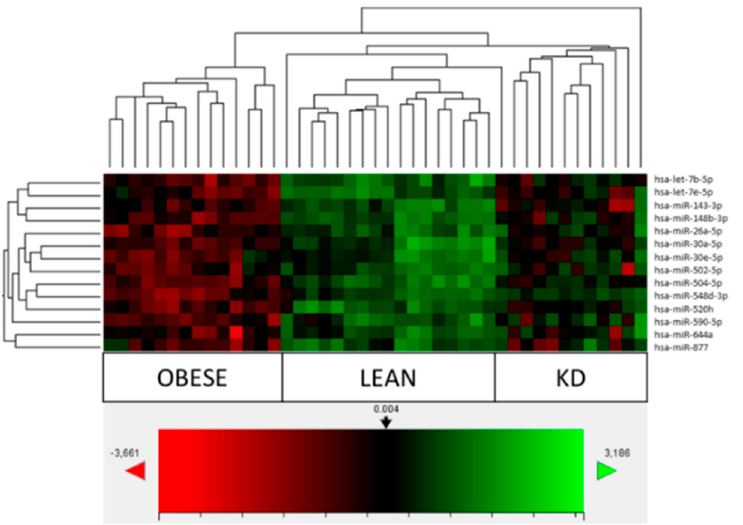
Figure 1. Heatmap and hierarchical clustering of obese ( n = 14), lean ( n = 17) and ketogenic diet (KD) subjects ( n = 12) based on the most differentially expressed microRNAs. The color and the intensity of the boxes represent changes of gene expression. In the analysis, red represents down-regulated genes and green represents up-regulated genes. Black represents an unchanged expression as evident by the color reference. n -Solver software was used.